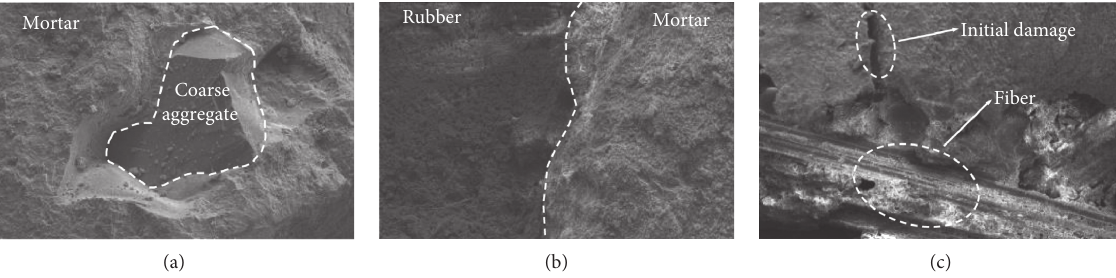
Figure 12: SEM of rubber fiber concrete. (a) C-0%-0%. (b) C-30%-0%. (c) C-30%-0.6%.